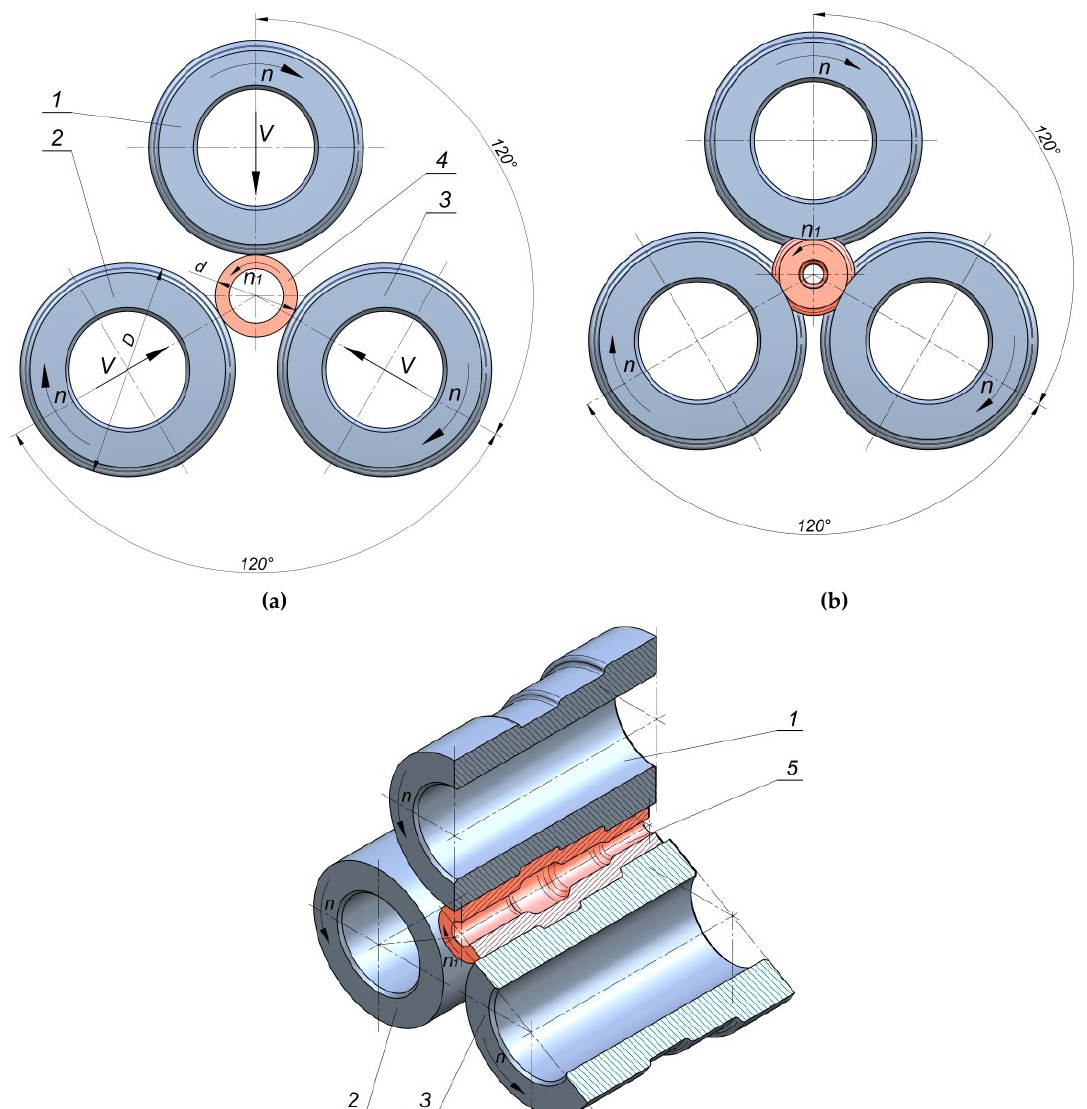
Figure 1. Scheme of rotational compression of hollow elements: ( a ) beginning of the process; ( b ) calibration of the forging; ( c ) end of the process and a formed forging. 1,2,3—rolls, 4—billet, 5—formed